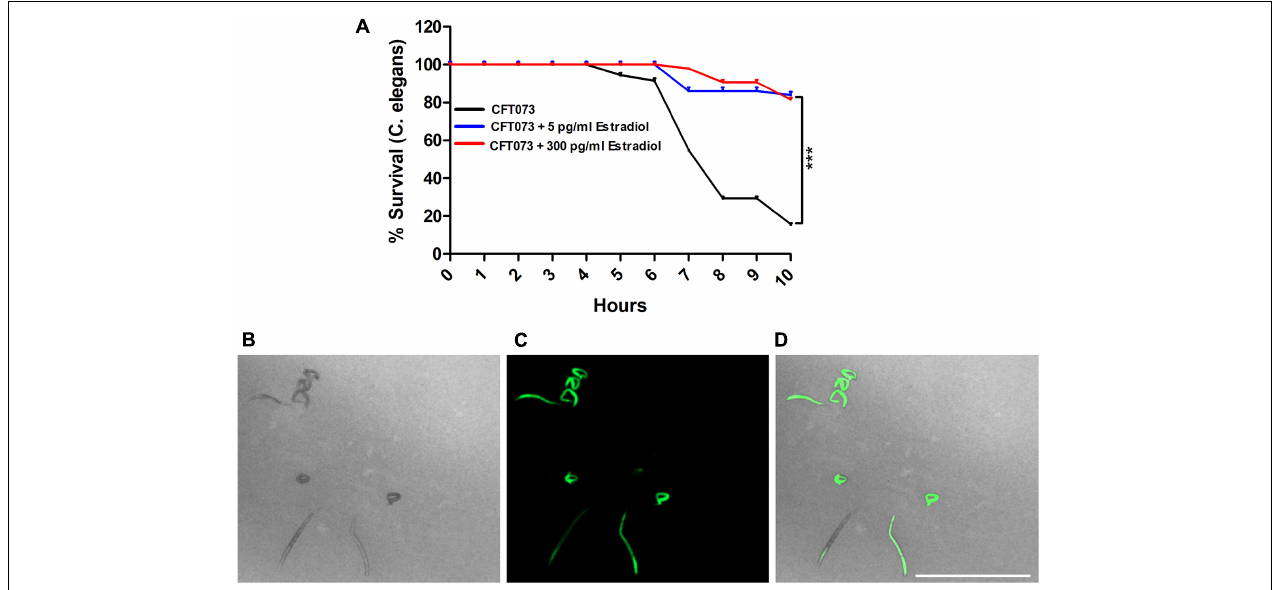
FIGURE 8 | CFT073 mediated C. elegans killing in the presence or absence of estradiol (5 and 300 pg/ml) (A) . Data are presented as mean ± SEM of n = 3 independent experiments. Statistical significance is denoted with asterisks: *** p < 0.001 vs. unstimulated CFT073. Immunofluorescence staining of dead worm with 1 µ M SYTOX Green (B–D) . Scale bar: 1,000 µ